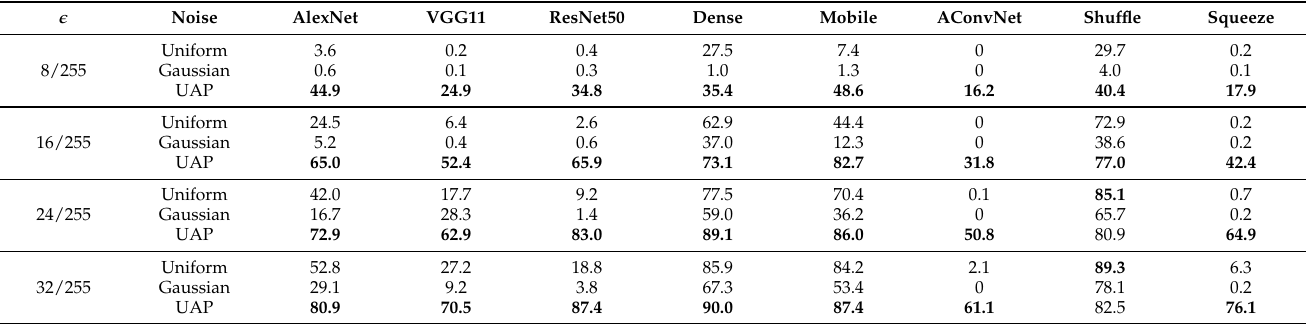
Table A2. Fooling ratio (%) of GD-UAP with VGG11 as substitute model and various (cid:101) . The deviation of Gaussian noise is set to (cid:101) /3 and the results of random noise are averaged on 10 runs.